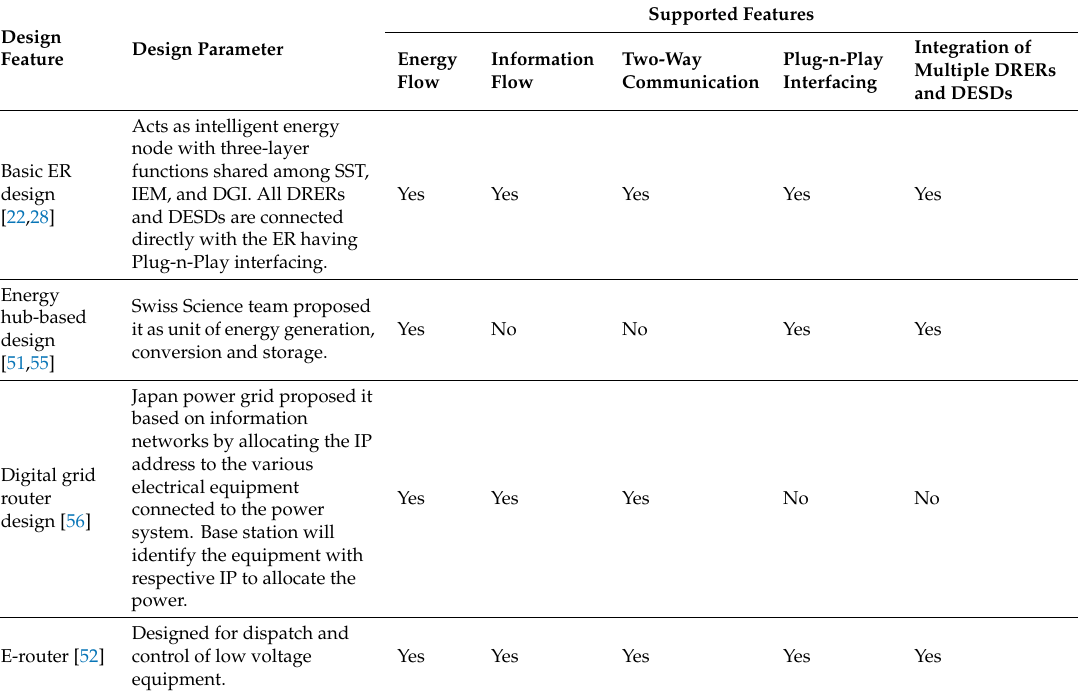
Table 1. Comparison between multiple designs of ER. DRER—distributed renewable energy resources; DESD— distributed energy storage